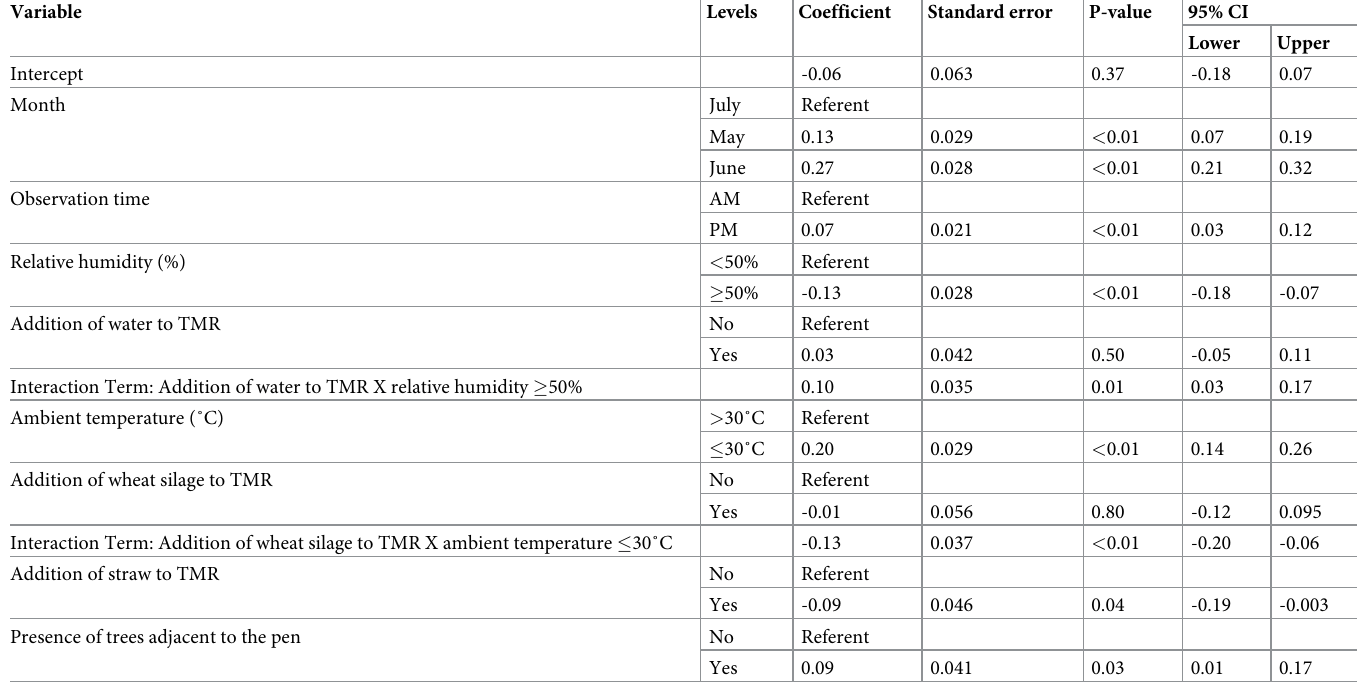
Table 1. Linear mixed model to estimate the association between the outcome log 10 mean leg count and explanatory variables study month, observation time, envi- ronmental factors, and addition of water, wheat silage, or straw to total mixed ration